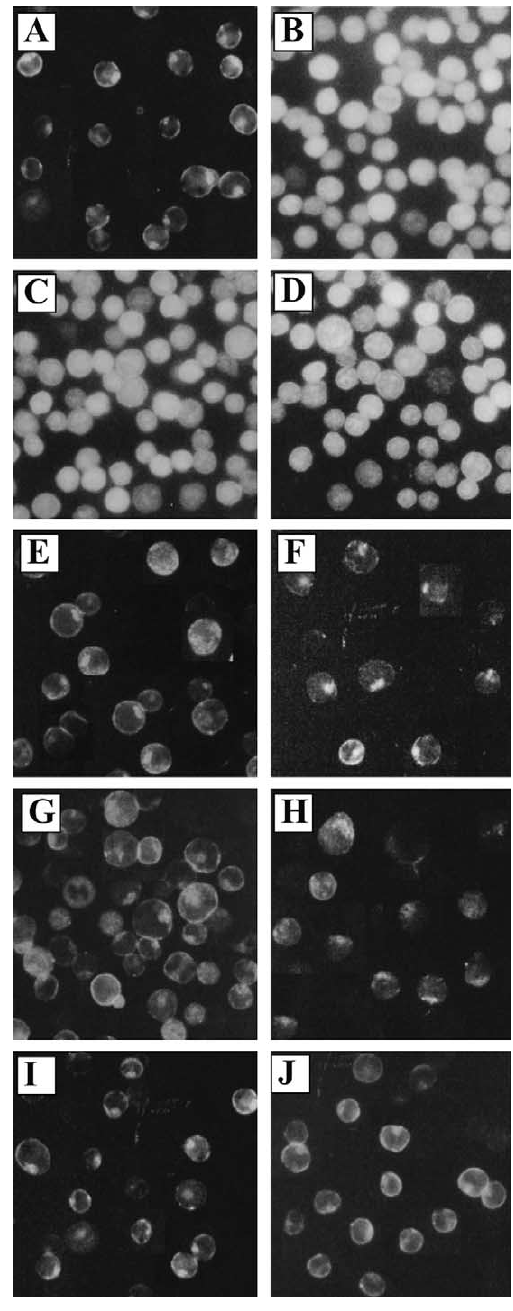
FIG. 5. Rp-8-Br-cAMPS and SB203580 inhibit the expression of ANXA1 induced by Dex, E 2 b or dBcAMP in CCRF-CEM cells. The cells were pre-treated with Rp-8-Br-cAMPS (500 m M) or with SB203580 (40 m M), for 1 h, before the addition of Dex (1 m M), E 2 b (1 m M) or dBcAMP (1 mM), for 12 h. The detection of total ANXA1 was performed by immunocyto- chemistry, as described in Materials and methods. (A) control, untreated cells; (B) cells treated with Dex; (C) cells treated with E 2 b ; (D) cells treated with dBcAMP; (E) cells treated with Rp-8-Br-cAMPS plus Dex; (F) cells treated with Rp-8-Br-cAMPS plus E 2 b ; (G) cells treated with Rp-8-Br- cAMPS plus dBcAMP; (H) cells treated with SB203580 plus Dex; (I) cells treated with SB203580 plus E 2 b ; (J) cells treated with SB203580 plus dBcAMP. The results shown are repre- sentative of three independent experiments.